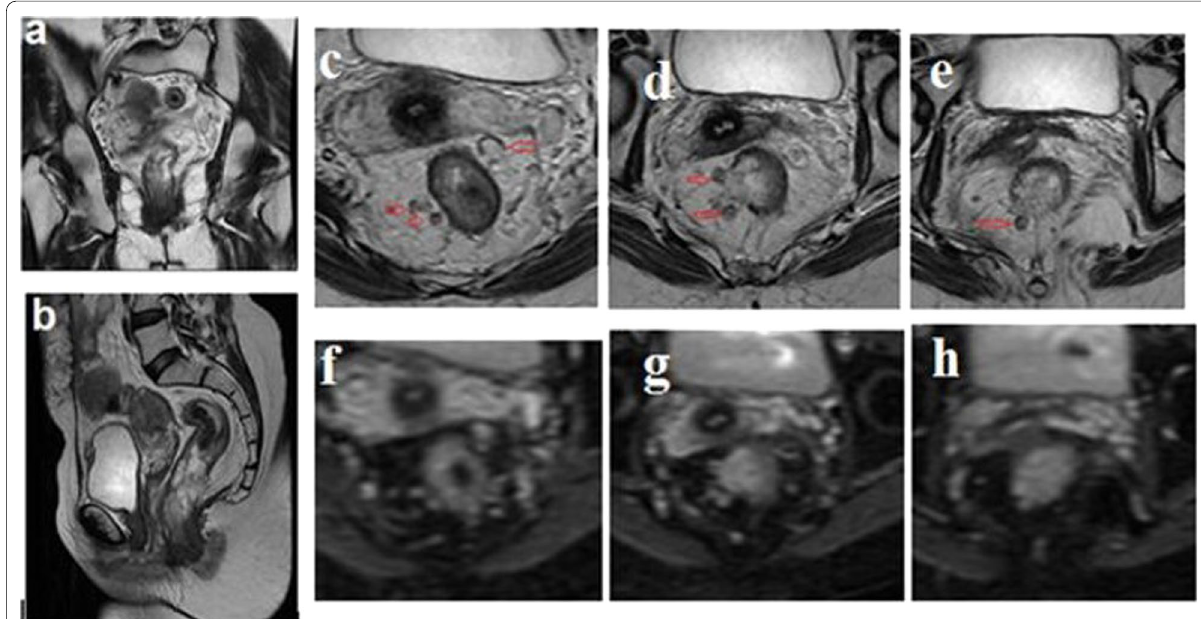
Fig. 4 a–h MRI study for 40 years old Female with pathologically proven cancer rectum and received radiotherapy . a, b coronal and Sagittal T2 WIs, c–e axial T2 & f–h DWIs, revealed irregular polypoidal mural thickening is seen involving the lower 2/3 of the rectum, involving the anorectal junction; with surrounding fat smudging; however no evidence of MRF infiltration with clear intervening fat plans. The lesion displays mixed T2 signal with the intermediate signal representing the tumoral residual while the hypointense signal denoting fibrotic changes. Multiple enlarged mesorectal and internal iliac lymph nodes are seen measuring up to 1.2 cm, displaying intermediate T2 and mild hyperintense signal on